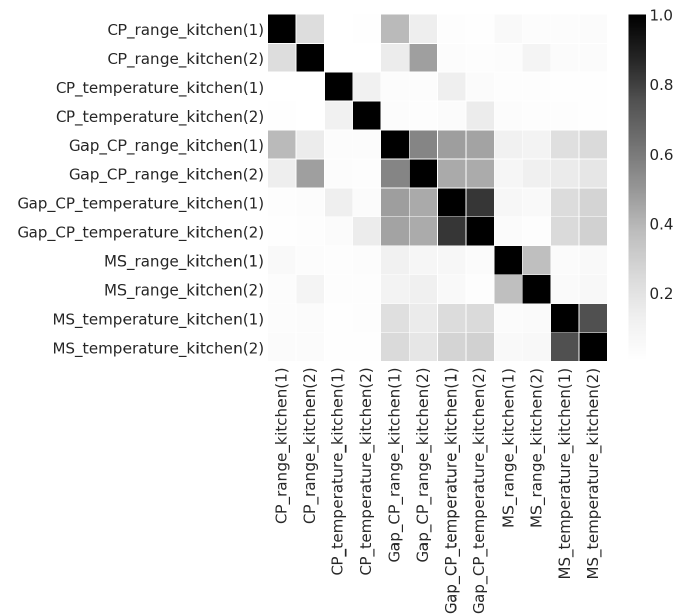
Figure 9. Correlations between the features of temperature and range readings from two sensor boxes installed in the kitchen of Household 1.